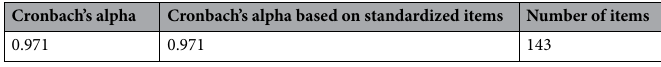
Table 2. Reliability statistics scale.